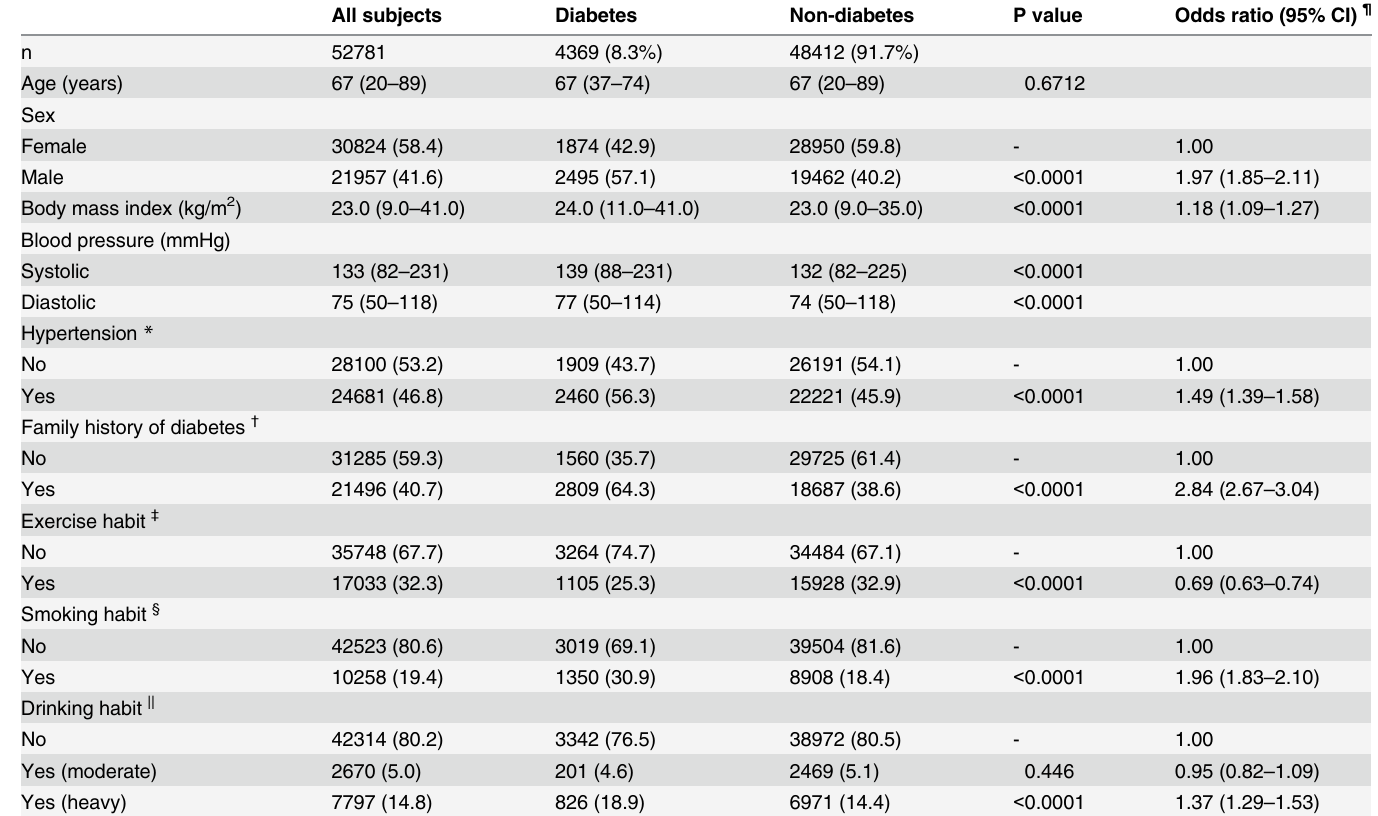
Table 1. Baseline characteristics of the study population .